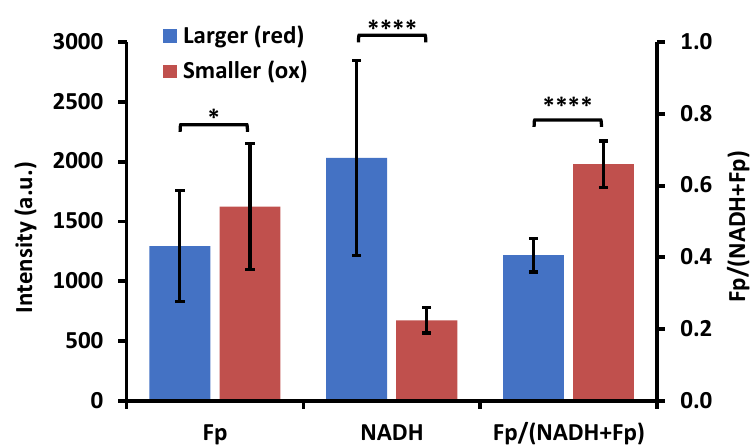
Figure 10. Quantified results for all three redox indices based on 30 cells per subpopulation selected from the four fields of view included those in Figures 9 and S1. * p < 0.05, **** p < 0.0001.